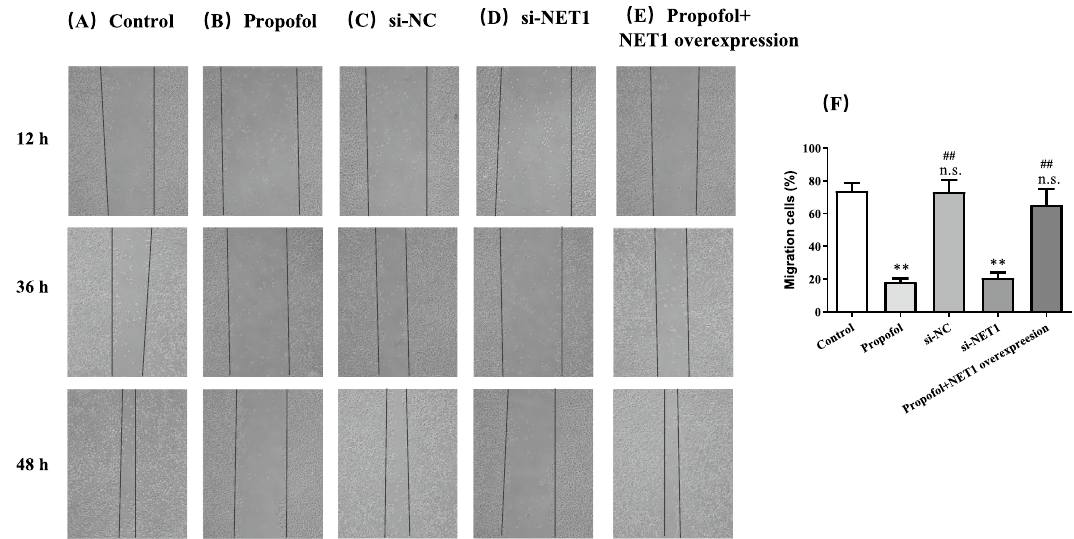
Figure 3. The treatment of 100 μM Propofol (Panel B ) or NET1 silencing (Panel D ) significantly inhibited SMMC‑7721 cell migration compared to control group (Panel A ) and NC group (Panel C ).While the inhibitory effect of propofol was offset by NET1 overexpression (Panel E ). Statistical analysis on SMMC‑7721 cell migration with indicted treatment (Panel F ). **P < 0.01 compared with control group, n.s. represented no significance compared with control group, # and ## denote P < 0.05, 0.01 compared with si‑NET1 group.